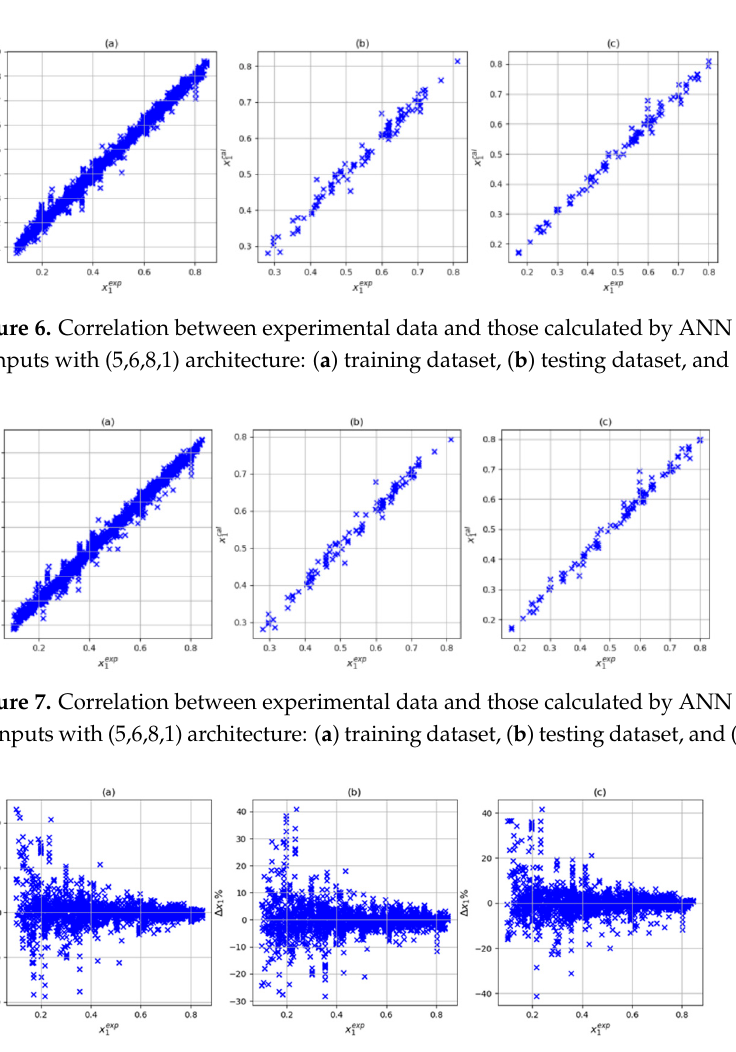
− 2.1911 Table 7. Weights and bias of the optimized ANN architecture for the first hidden layer to the second hidden layer. j